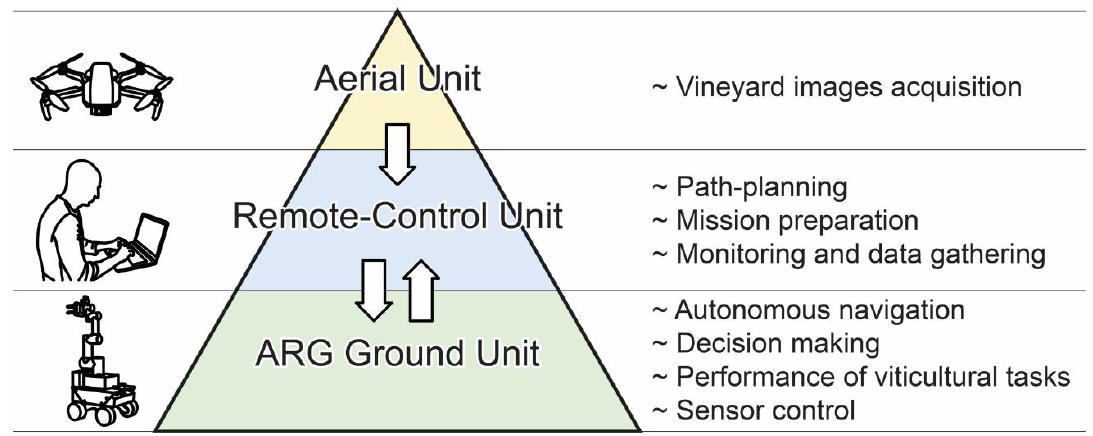
Figure 1. Conceptual system architecture and interoperability of the system units.